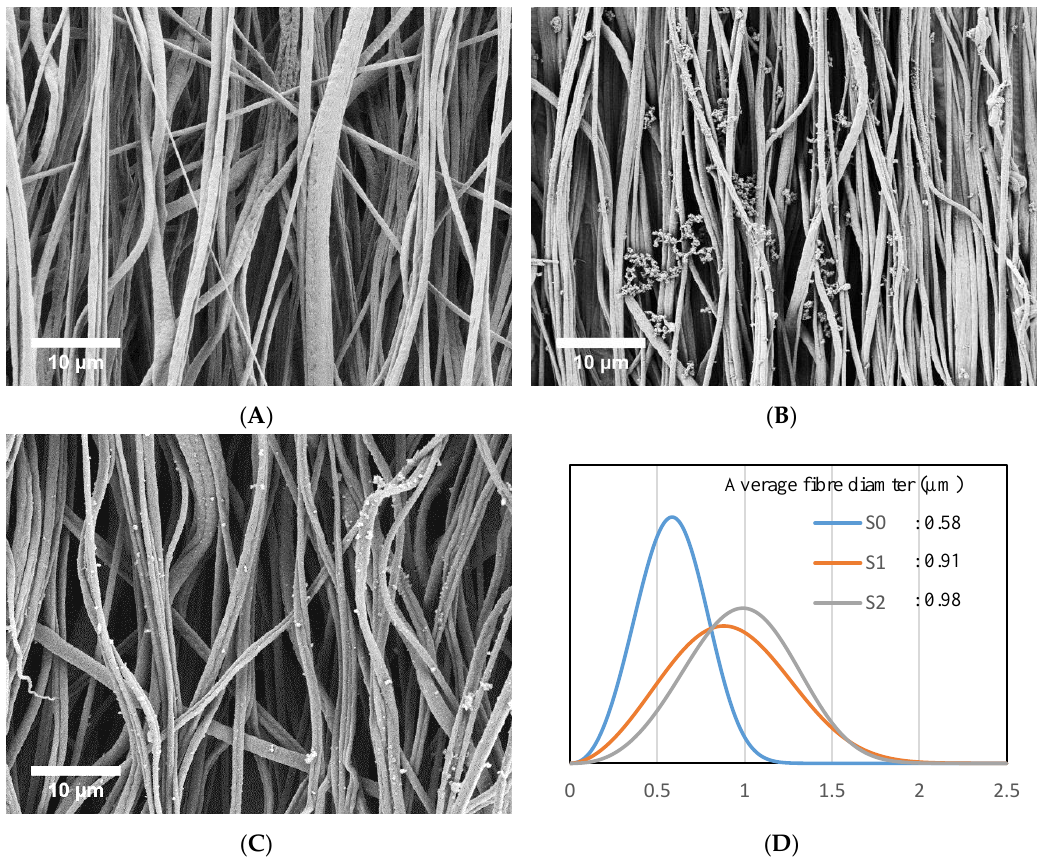
Figure 2. The morphology of the fibers and the fiber diameter distribution. ( A ) Aligned PCL fibers without coating (S0); ( B ) Aligned PPy-coated PCL fibers (S1); ( C ) Plasma-treated aligned PPy-coated PCL fibers (S2); ( D ) Fiber diameter distribution by Weibull curve fitting.